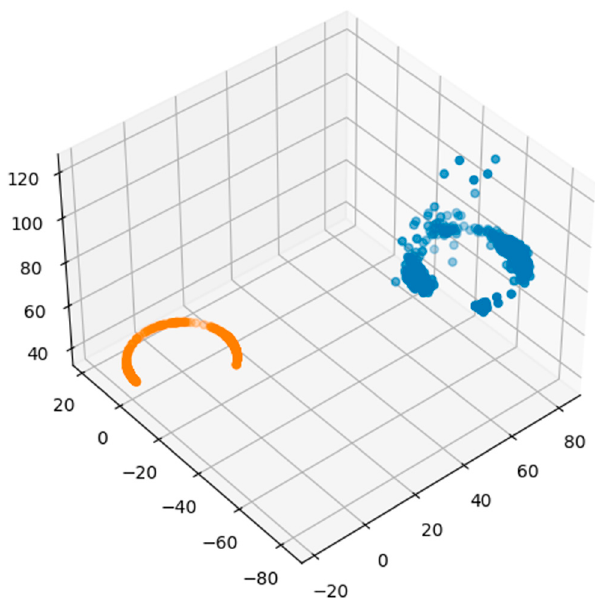
Figure 4. Measured data after a certain path (blue color), calculated data (orange color).